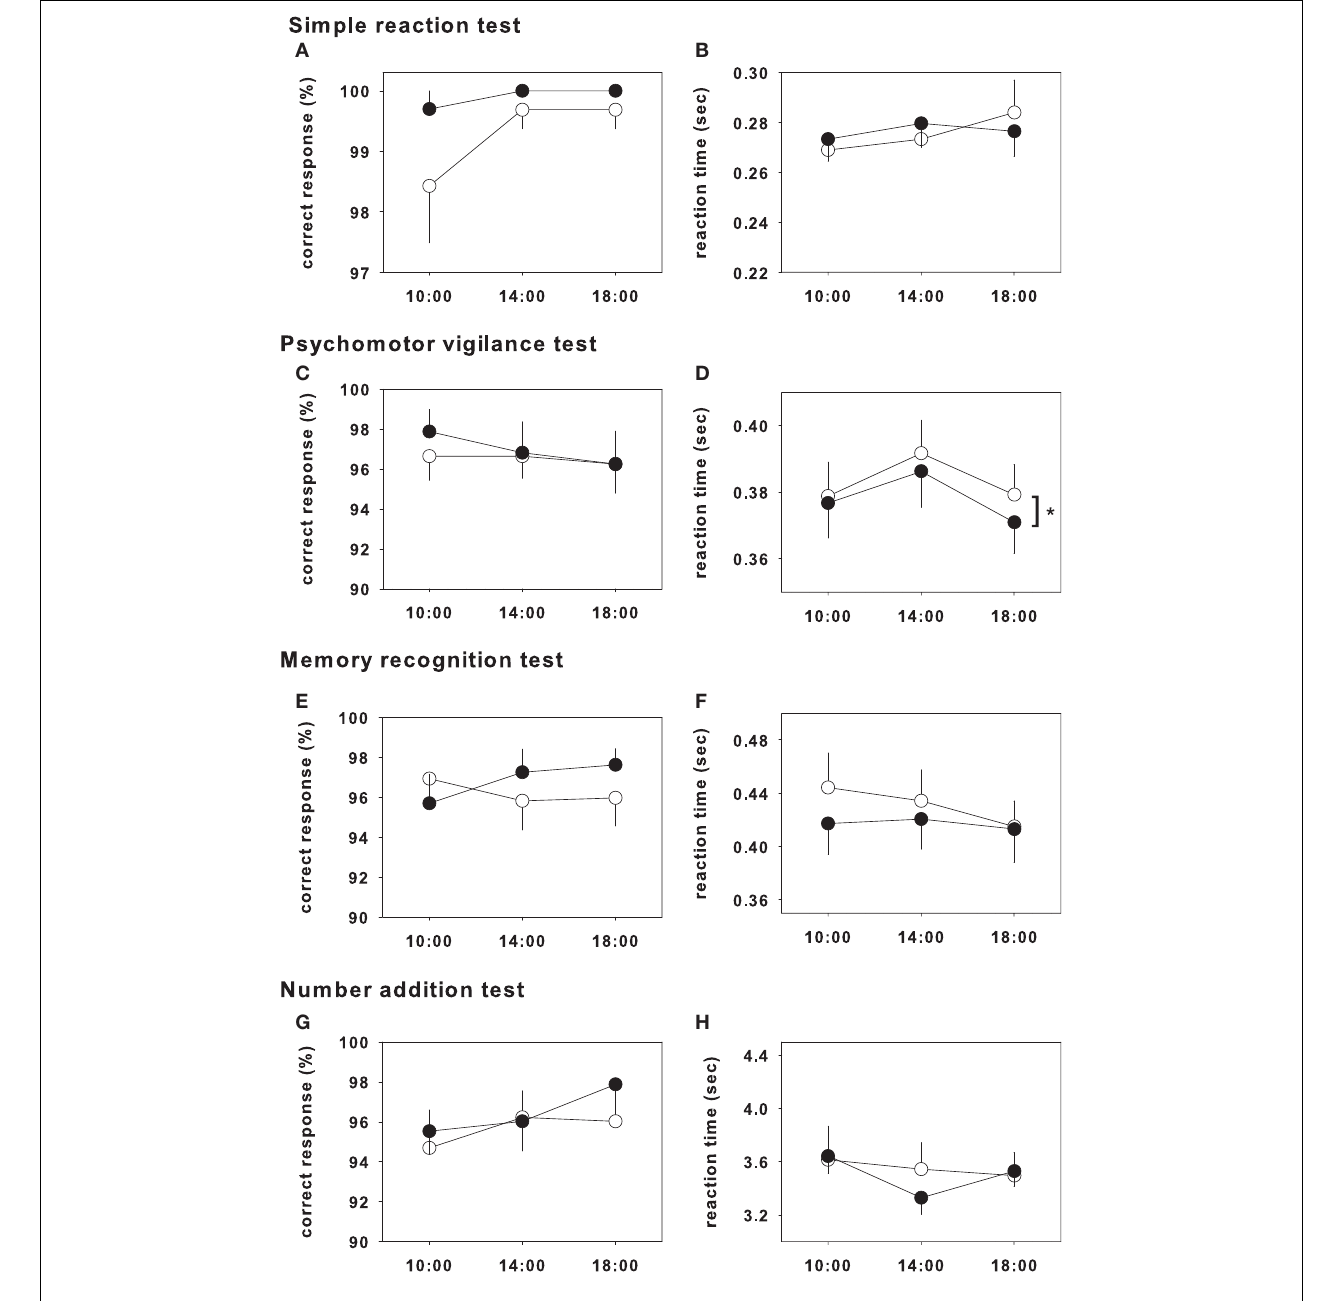
memory recognition test (E,F) and number addition test (G,H) showed no significance. Psychomotor vigilance test showed significant effects in reaction time (D) , however that of correct response did not showed significance (C)